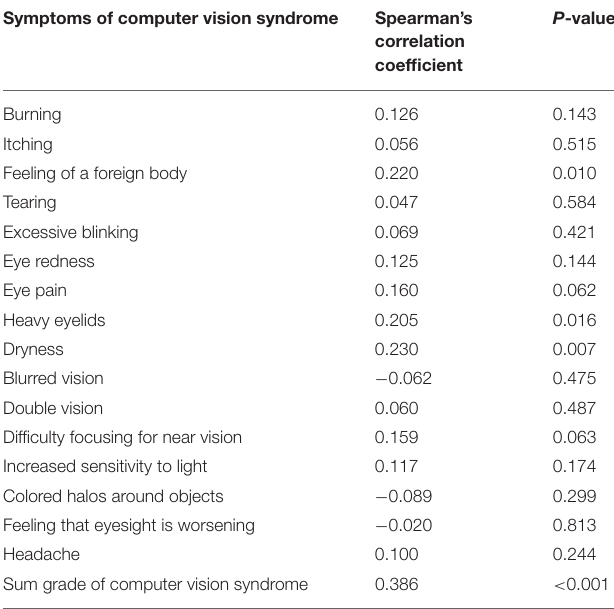
TABLE 1 | The correlation of digital screen time with grades of symptoms of computer vision syndrome. Symptoms of computer vision